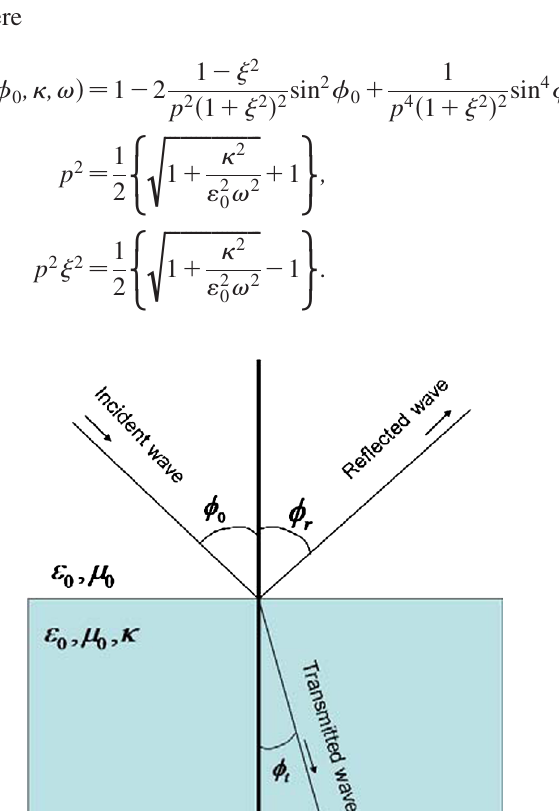
FIG. 3. Transmission and reflection of an EM wave on vacuum-conductor boundary